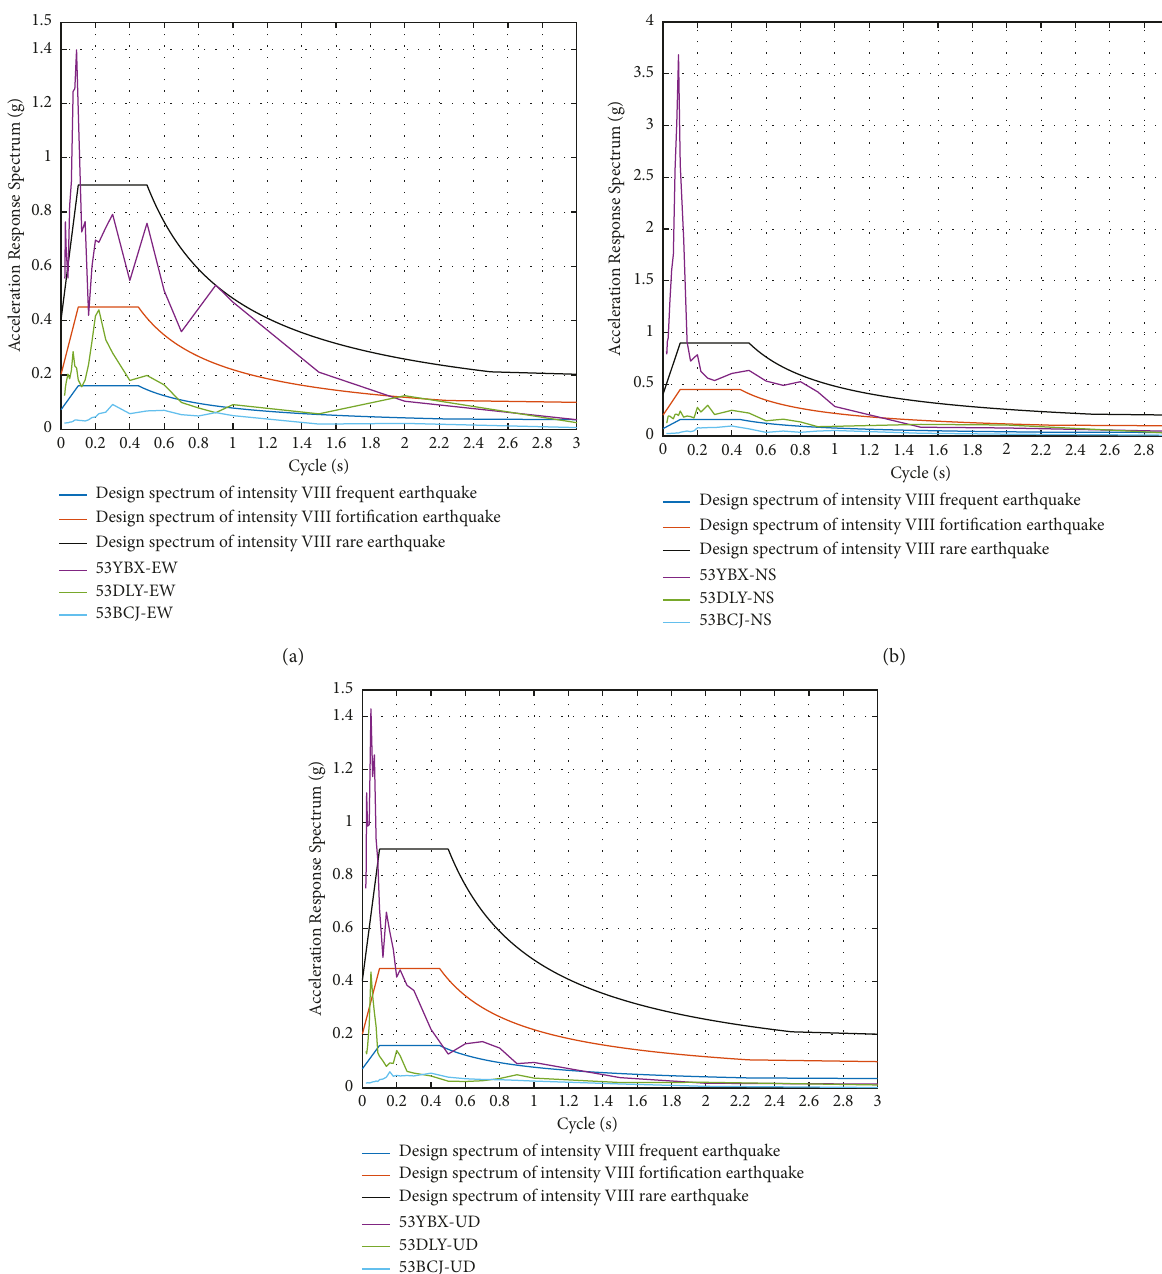
Figure 5: Comparison of acceleration response spectra (Sa) and code design spectra among stations with different epicentral distances: (a) east-west; (b) north-south; and (c) vertical. Note: all acceleration response spectra involved in this section are acceleration response spectra (Sa) with a damping ratio of